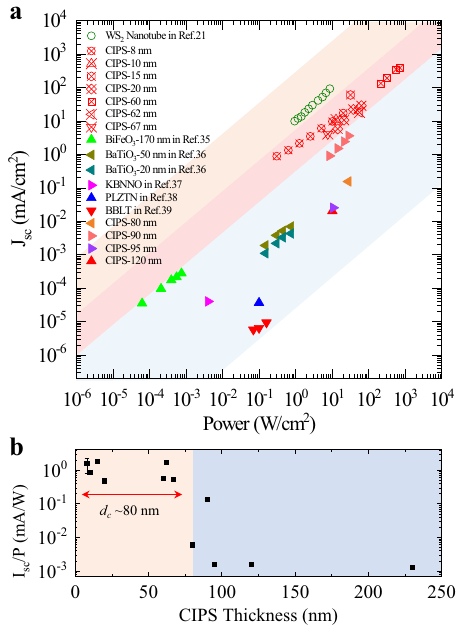
Fig. 5 The dimensionality factor of the BPVE. a An overview of the photovoltaic performance in 1D, 2D, and 3D BVPE materials. The paralleled polygons fi lled in yellow, red, and blue represent the short-circuit photocurrent density from 1D, 2D, and 3D bulk photovoltaics respectively. With the same illumination power density, the photocurrent density from 2D ferroelectric CIPS falls in the gap between 1D and 3D bulk photovoltaics. b The thickness dependent BPVE in ferroelectric CIPS. For each device with different fi lm thicknesses, the observed short-circuit photocurrent is normalized by the incident light power. The I sc decreases to the 3D noise level as the CIPS is thicker than 80 nm, indicating the free path length of the hot photocarriers to be about 40 nm, using the estimation of d c (cid:5) 2 l 0 . A similar conclusion can be achieved by the open circuit voltage, as shown in the Supplementary material of Fig.